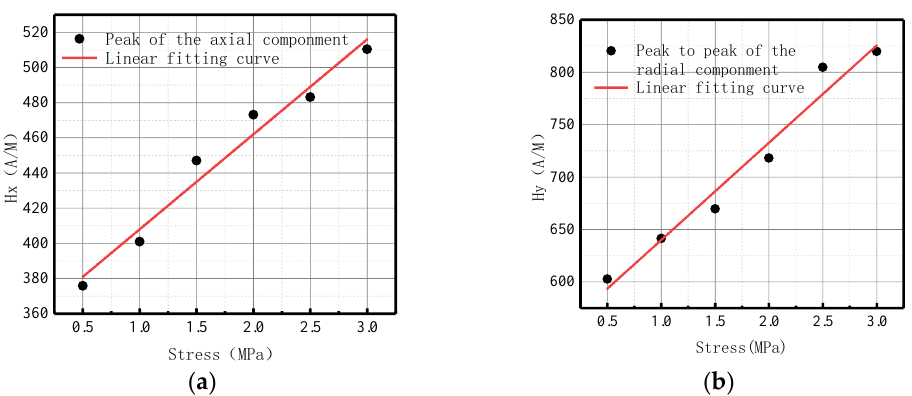
Figure 13. The peak values of weak magnetic signal at weld crack changes with internal pressures. ( a ) Peak values of the axial component; ( b ) peak-to-peak values of the radial component. It was revealed that the peak values in axial and radial components increased linearly with internal pressure. For an increase of pressure with an interval pressure of 0.5 MPa, the average change of peak value in the axial component was 83.33 A/M, and the average change of peak-to-peak value in the radial component was 137.5 A/M.